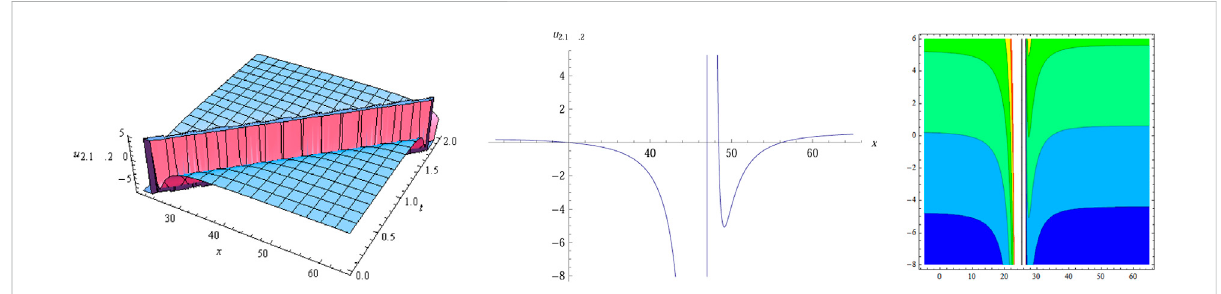
FIGURE 2 3D plot, 2D plot, and contour plot of u 2 . 1 . 2 with α (cid:2) 1 , β (cid:2)